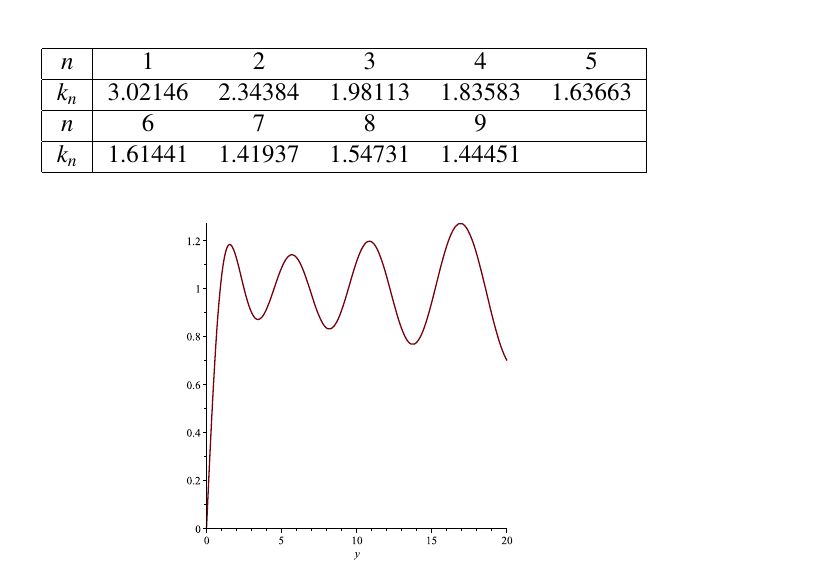
Table 2. Approximate value of the constant k n , for k = 1 ,..., 9